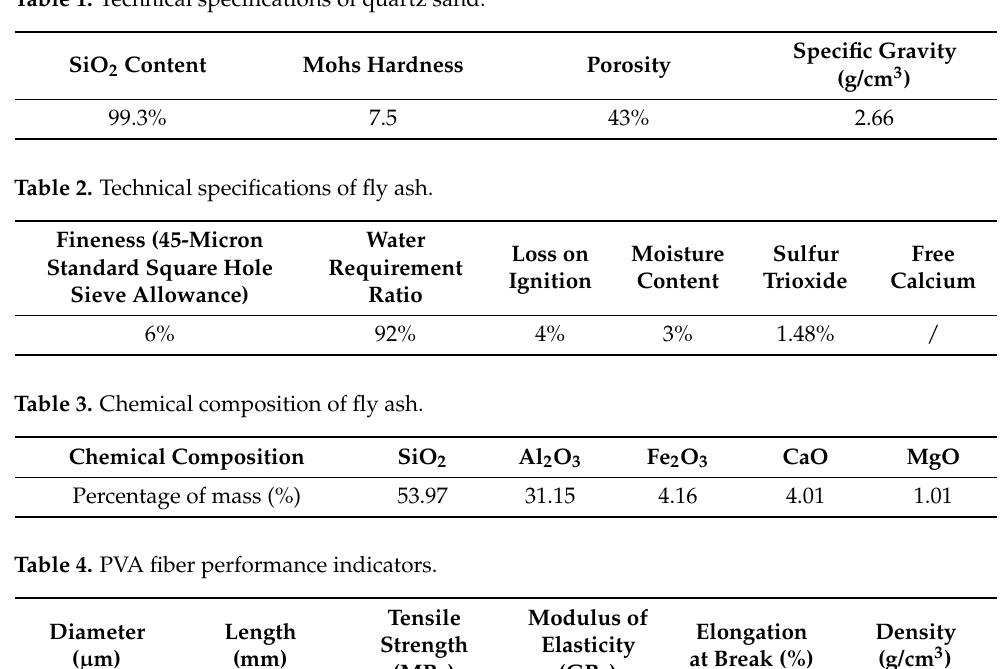
Figure 1. Particle size distribution of KH 2 PO 4. Table 1. Technical specifications of quartz sand.